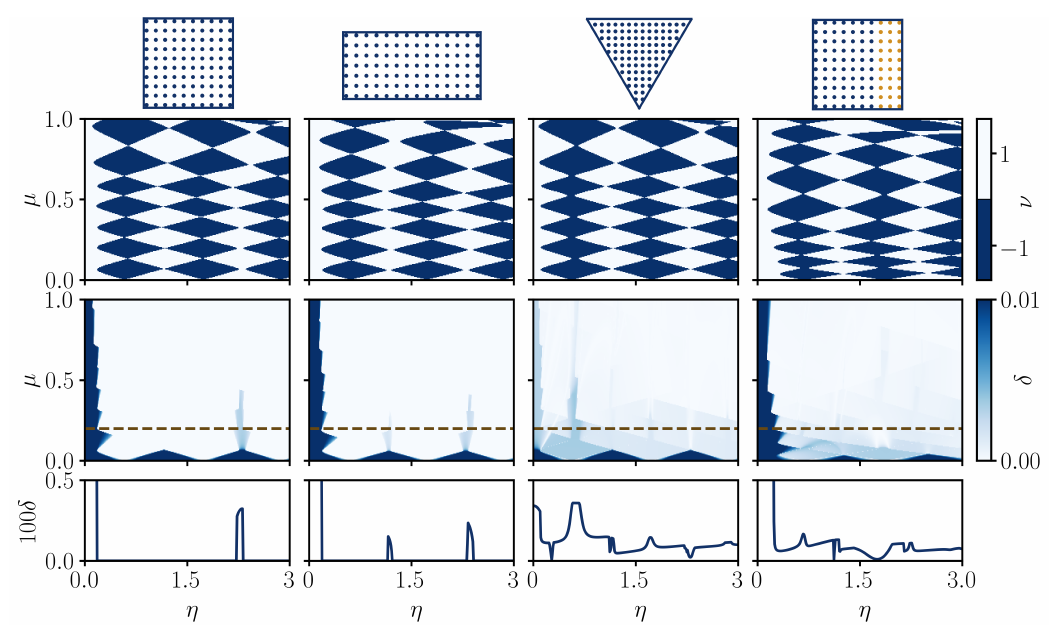
Figure 6: Topological invariant and gap for different ways of breaking the C tion, in the absence of a vortex in the order parameter. The top row shows the wire geometry: from left to right, the C invariant square wire for reference; a rectangu- 4 = 10, N = 7 and only C lar wire with N rotational symmetry; the triangular wire x y 2 from Fig. 5, where all symmetries are lost; and a square wire where the proximity > 7, representing the situation described in Fig 1. effect is finite only for sites with N x Second row is the Kitaev number, and third row the gap estimate. The fourth row zooms in on the dashed lines in the third